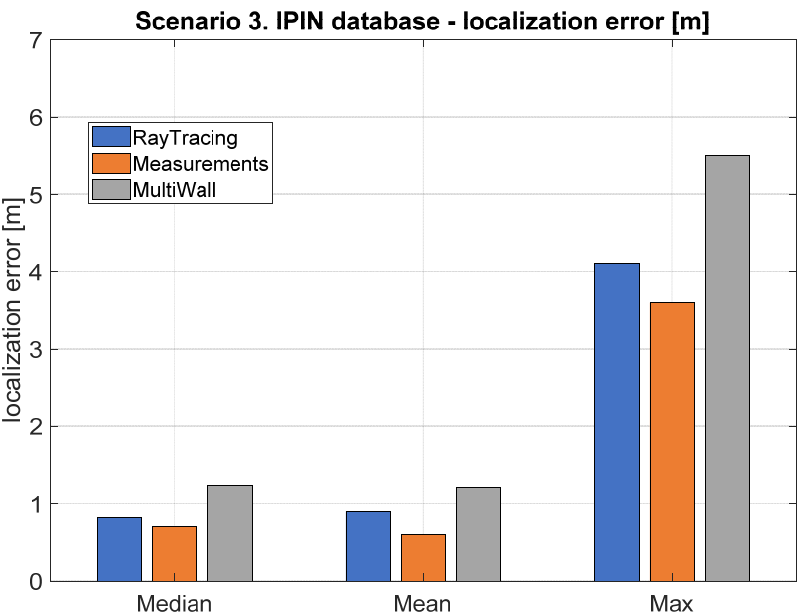
Figure 18. Localization error for an indoor environment (from the IPIN database). Data obtained using reference RSSI datasets prepared by different methods.